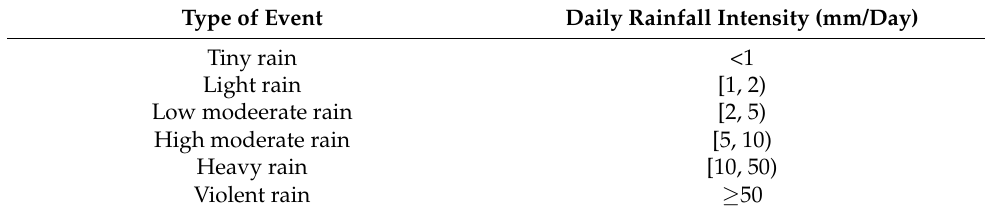
Table 3. Precipitation event classification based on daily rainfall